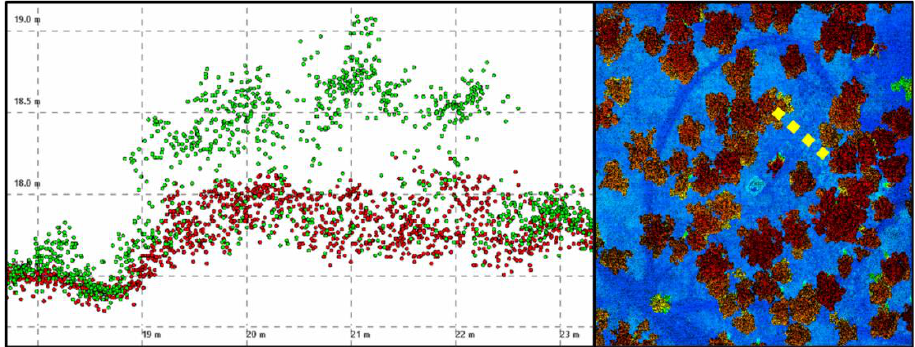
Figure 3. Pre- (Green) and Post-fire (Red) LiDAR point clouds for a 6 m sample profile along the transect presented in ( Right ) the overview map as a yellow dash line ( Left ).